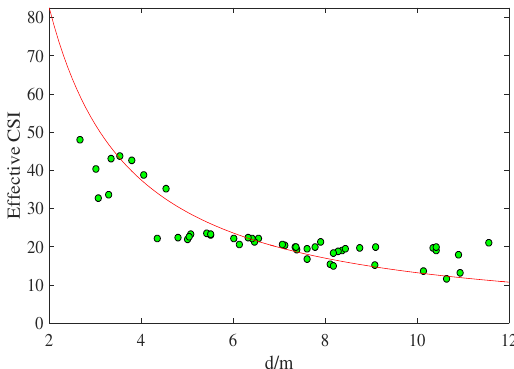
Figure 7. Path loss exponent calculation: n =